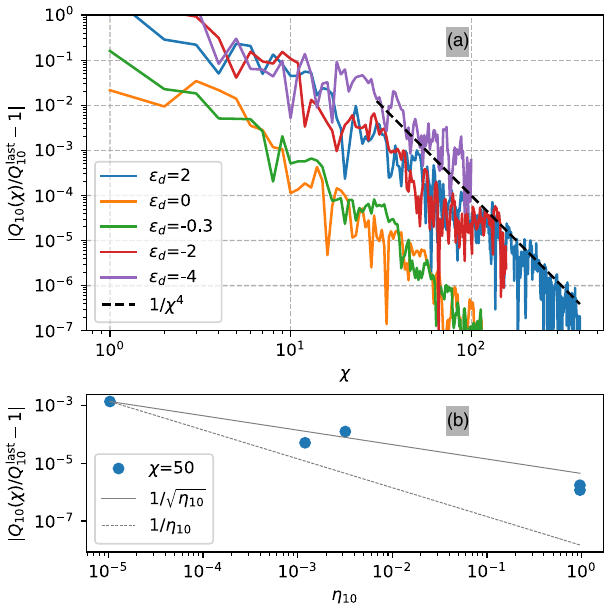
FIG. 13. (a) Upper: error of Q 10 versus χ in the SIAM model, for different ϵ . Gauss-Kronrod integration is used with d ¼ 31 d 2 ; 0 ; − 0 . 3 and d ¼ 255 points for ϵ points for ϵ d ¼ (b) Lower: the same error, but for fixed χ ¼ 50 , varying η 10